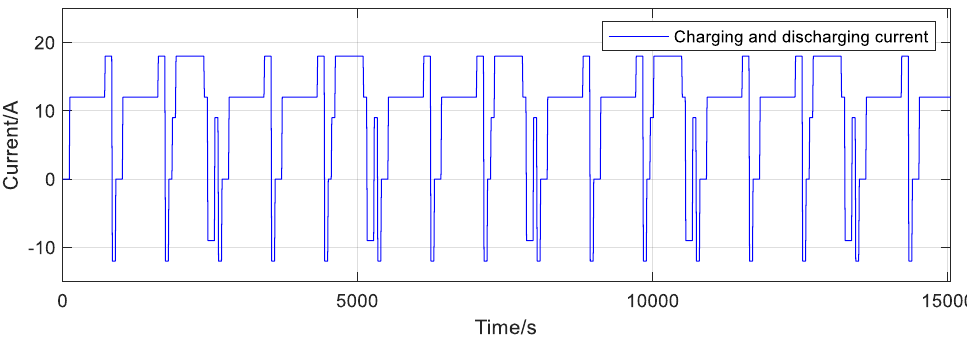
Figure 7. Charge and discharge current waveform of dynamic stress testing (DST) experiment.